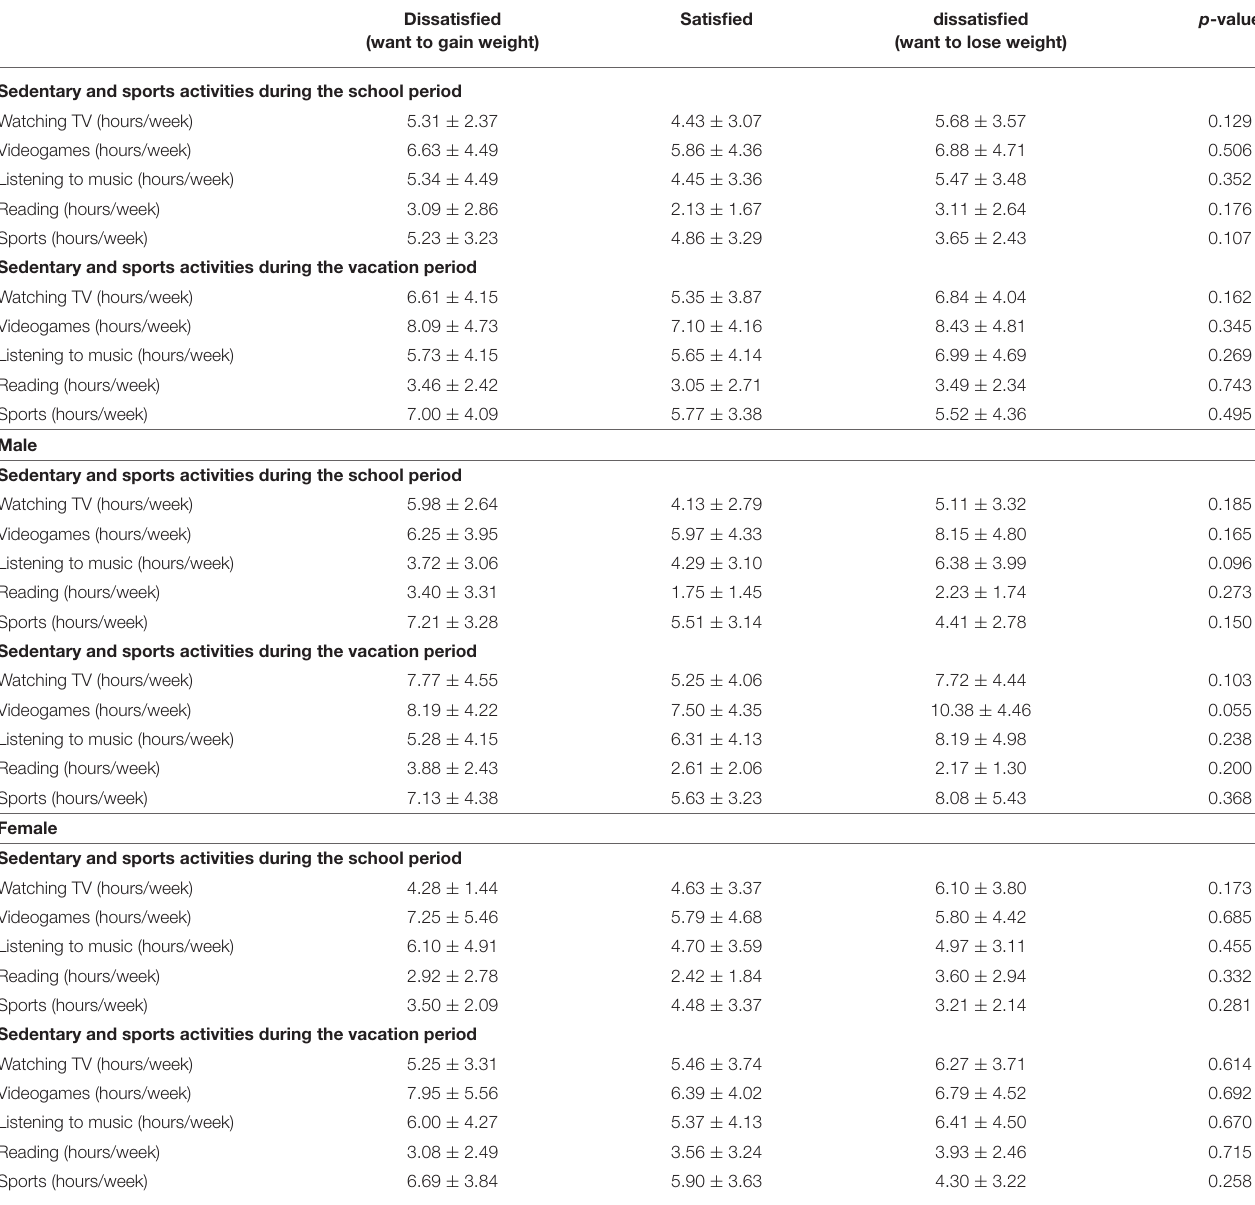
TABLE 3 | Descriptive statistics of the duration of time spent by the students on sedentary and sports activities.